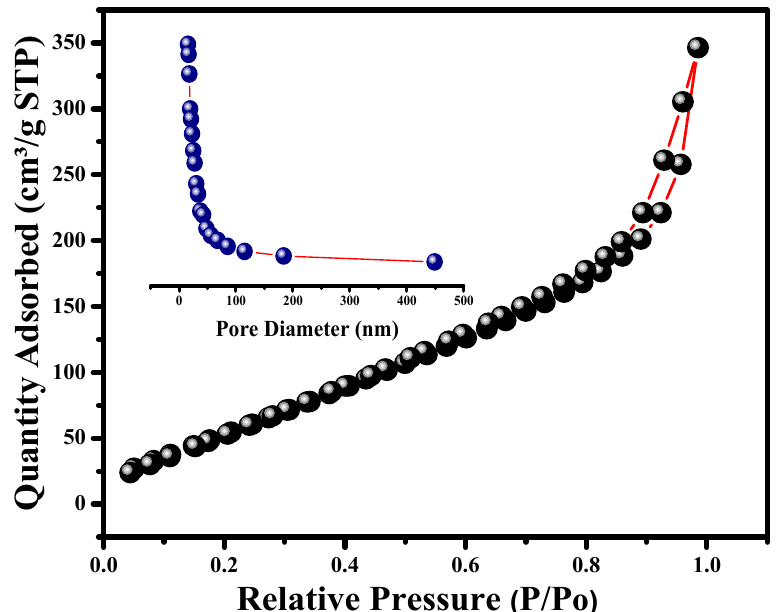
Figure 3. BET surface area (inset pore distribution).